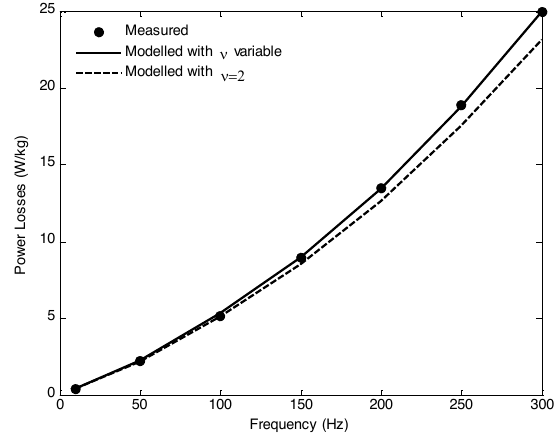
FIGURE 9. Modelled and measured hysteresis loops at 300 Hz with n variable Figure 10, shows the power losses modelled and measured for various frequencies, and figure 11 shows the difference between the modelled and measured values. It is clear that the computed power losses with n variable compared to experiment give accurate results than those evaluated by using n =2.